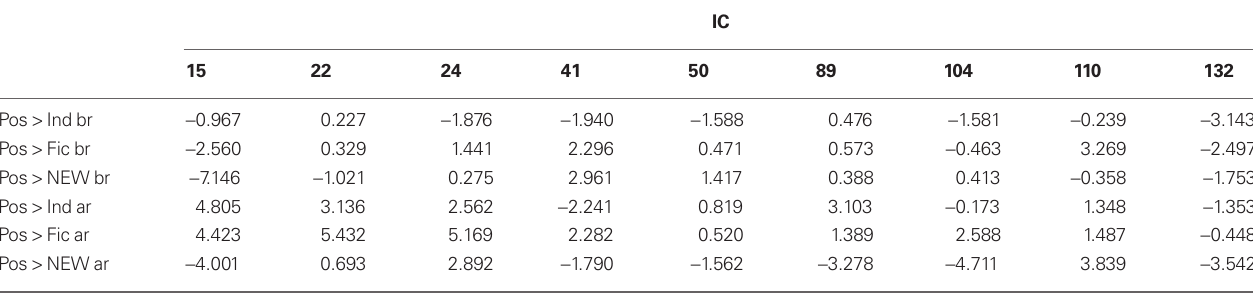
Pos, positive; Ind, indifferent; Fic, fictitious; NEW, non-emotional words (baseline); br refers to the participation of the voxel before the response (decision stage); ar refers to the participation after the decision instant but before the stimulus offset.